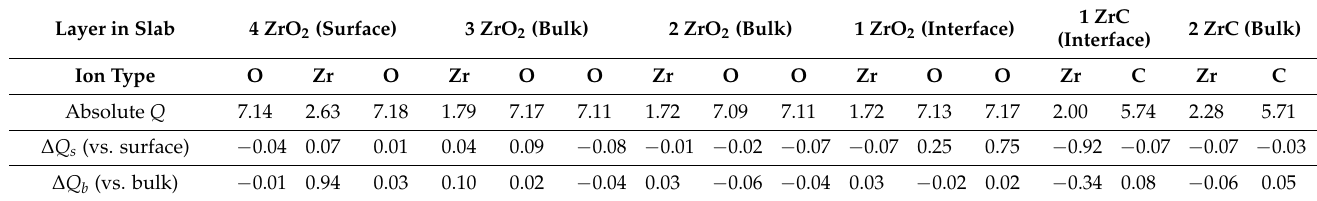
Table 6. The spatial profile of charge transfer is arranged along the normal direction of the interface. ∆ Q s is the difference in the charge of the ion with the corresponding ion in the isolated surface slab used to create the interface, and ∆ Q b is the difference in charge between the ion and the corresponding ion in the bulk